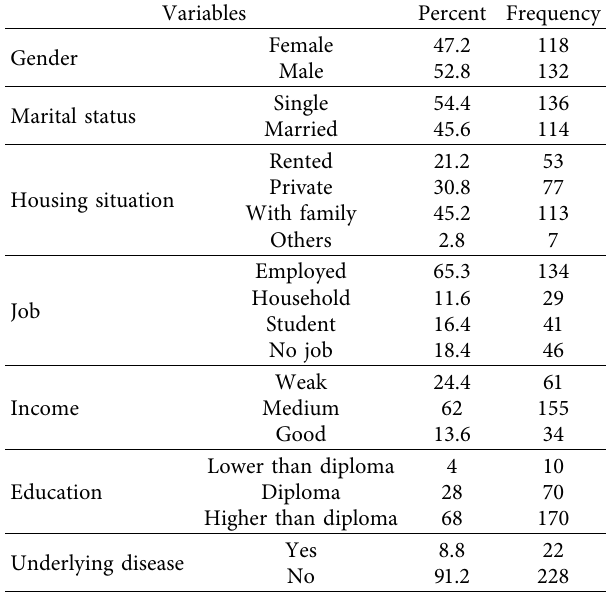
Table 1: Distribution of relative and absolute frequencies of de- mographic variables in research